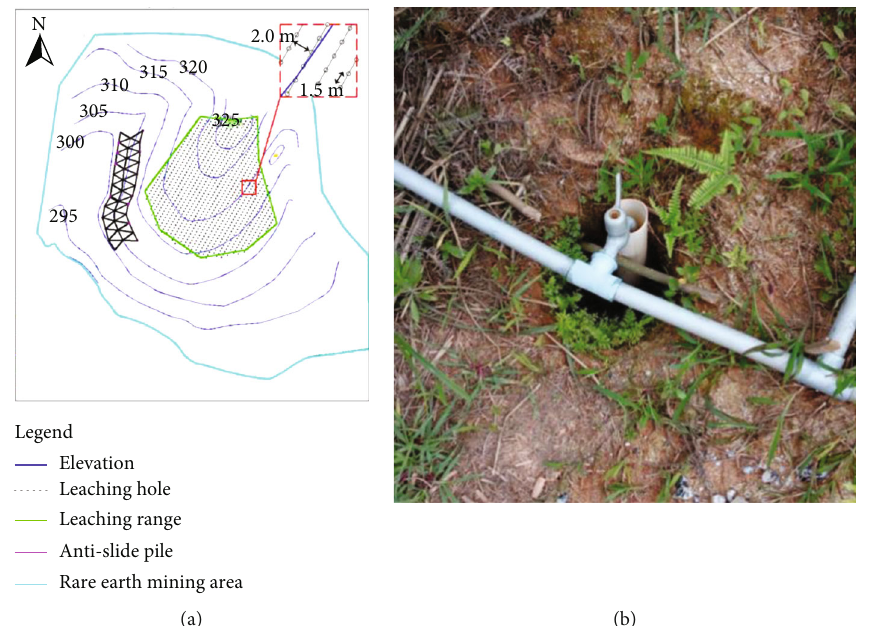
Figure 4: Schematic diagram of the leaching system. (a) The layout of the injection hole layout. (b) The installation of the injection